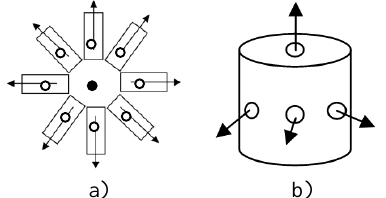
Figure 2. A general idea of positioning individual cameras in immersive system. a) a top view of panoramic rig; b) a front view of spherical device with one lens looking up.